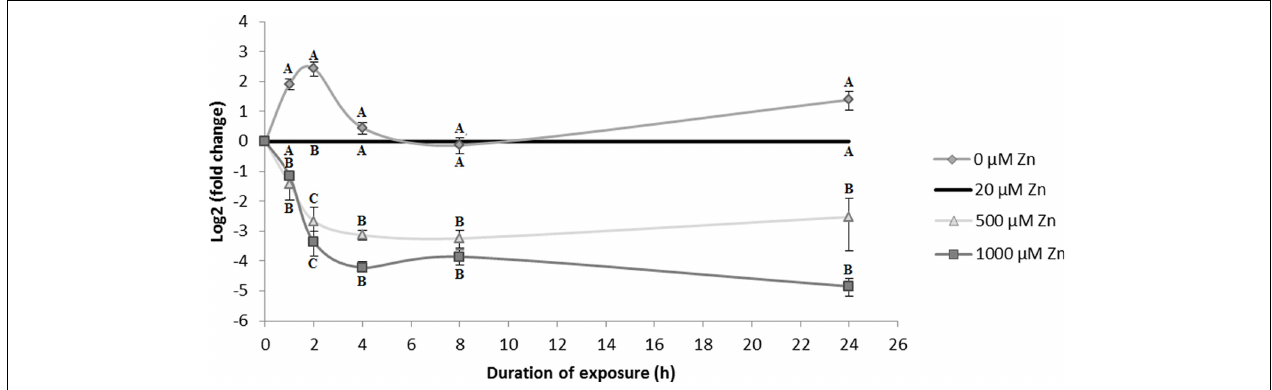
FIGURE 6 | SlZRT1 gene expression in S. luteus mycelium after 0, 1, 2, 4, 8, and 24 h exposure to different concentrations of Zn. Data are the average ± SE of three biological replicates and expressed as fold change to the control condition (20 µ M Zn) within each time point. Mean values were log2 transformed. Significant differences ( p < 0.05) within each time point are indicated by different